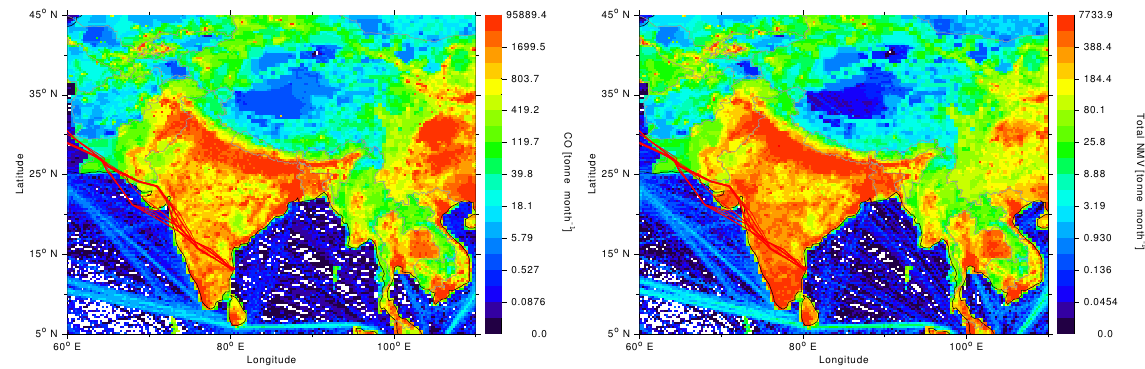
Figure 2. Emissions of CO (left panel) and non-methane volatile organic compounds (right panel) for August 2008 from the Regional Emission inventory in ASia (REAS) v2.1 (Kurokawa et al., 2013) including the update from 14 November 2013. The red lines mark